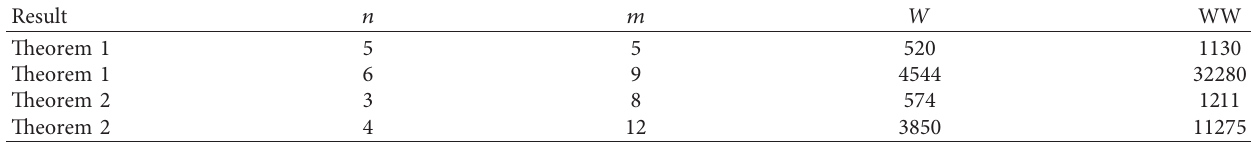
Table 1: Wiener and hyper-Wiener indices the cylinder.